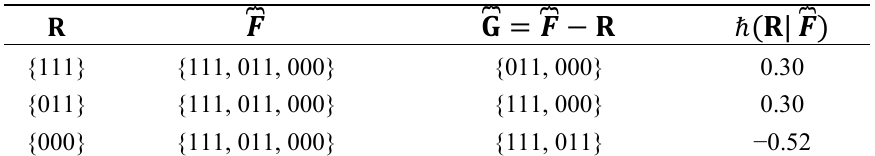
representations of (cid:1832)(cid:3598) .